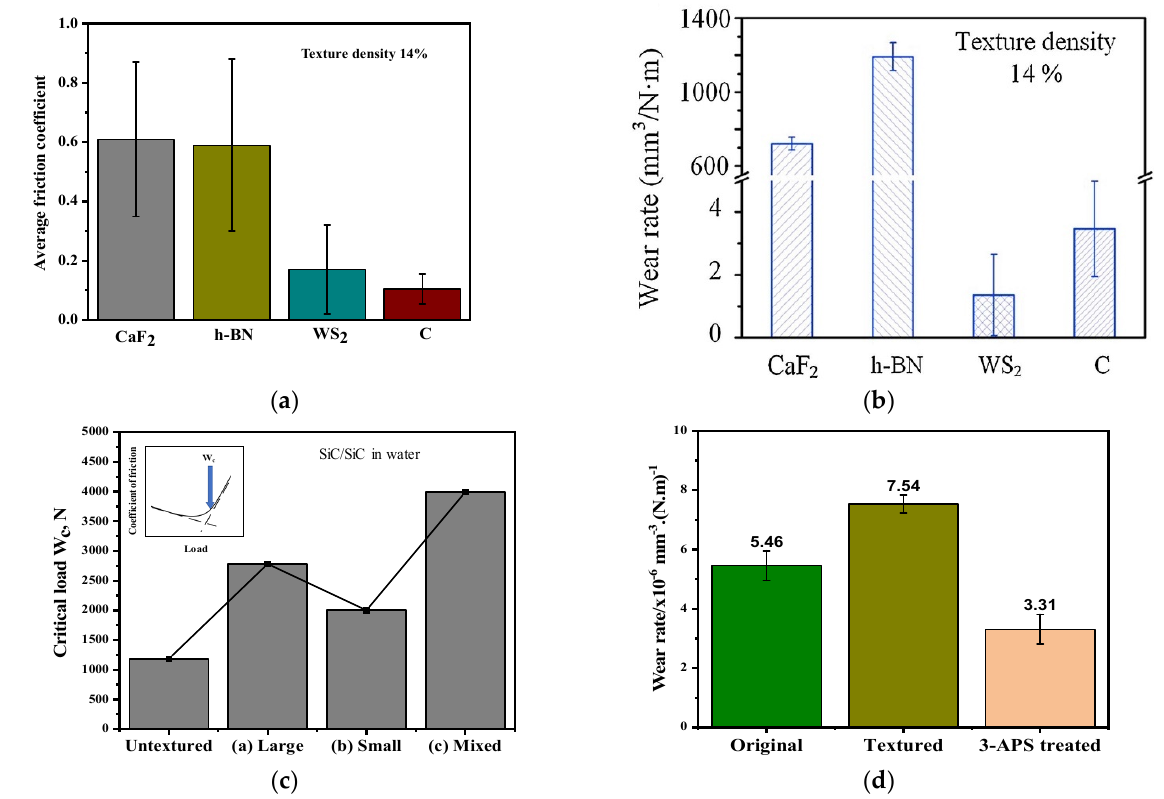
Figure 11. ( a ) COF and ( b ) wear rate of patterned surfaces burnished with CaF 2 , h-BN, WS 2 , and graphite solid lubricants, reprinted with permission from [127], copyright from Elsevier 2019; ( c ) Critical load of non-textured and textured samples, reprinted with permission from [132], copyright from Elsevier, 2006; ( d ) wear rates of different Al-bronze surfaces, reprinted with permission from [139], copyright from Elsevier, 2020. Table 4. Effects of various lubricants on surface texture.